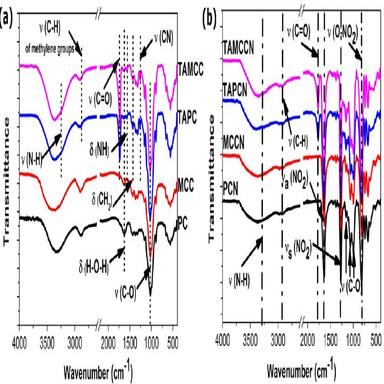
IR spectra of (a) unmodified precursors and their functionalized derivatives; (b) nitrated polymers.